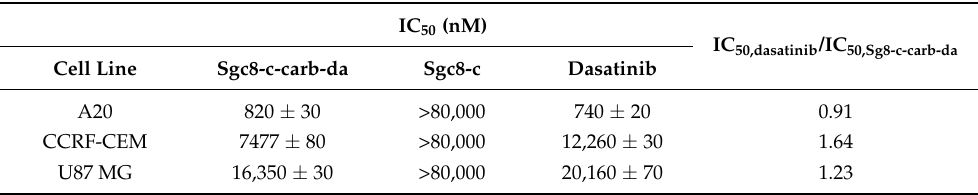
Table 1. Cytotoxic effects of Sgc8-c-carb-da , dasatinib, and Sgc8-c against A20 cells, PTK7-positive CCRF-CEM, and negative U87 MG controls, expressed as IC 50